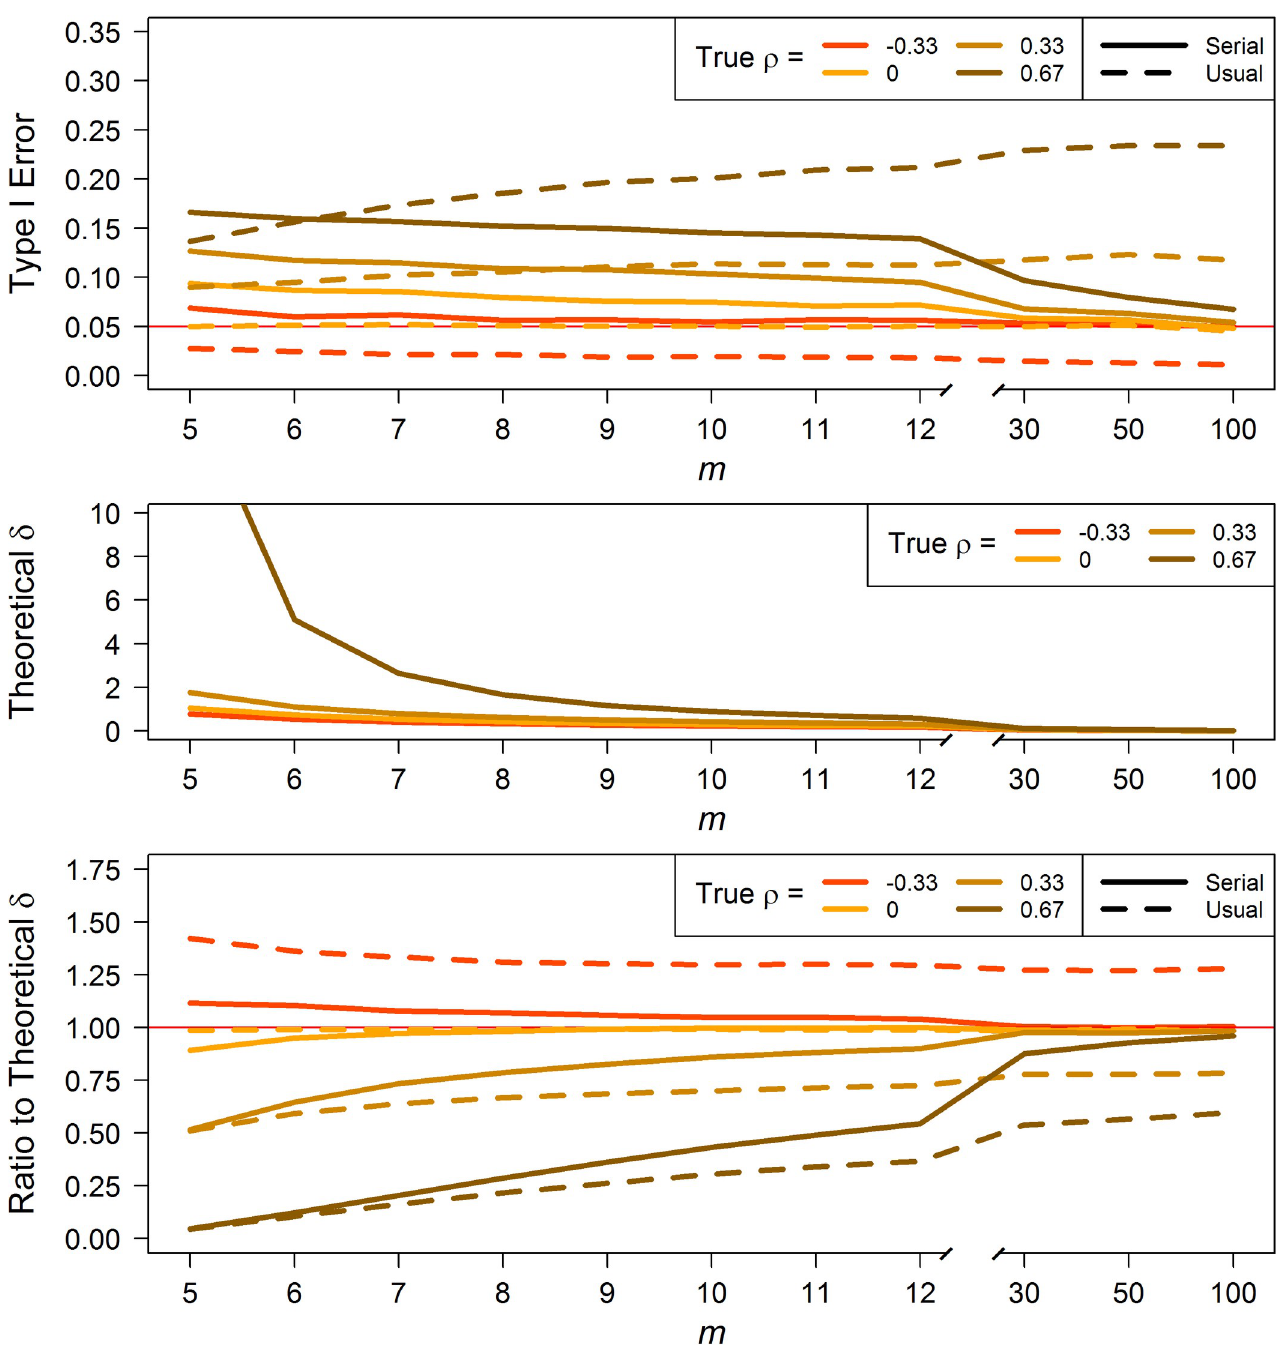
Fig 4. Paired t -test for rate-change. Type I error (top) and theoretical effect size, δ , computed using Eq 13 for 80% power with a one-sided 5% significance level test for a given m (middle). Ratios (bottom) of serial and usual δ (estimated from simulation) to the theoretical δ under same conditions as the theoretical δ .